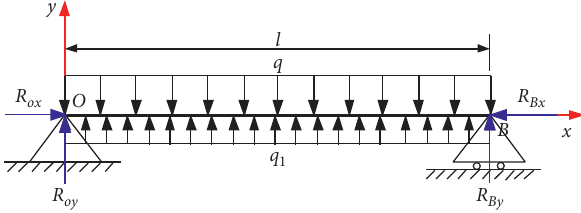
Figure 20: Mechanical model of the composite suspended rock beam